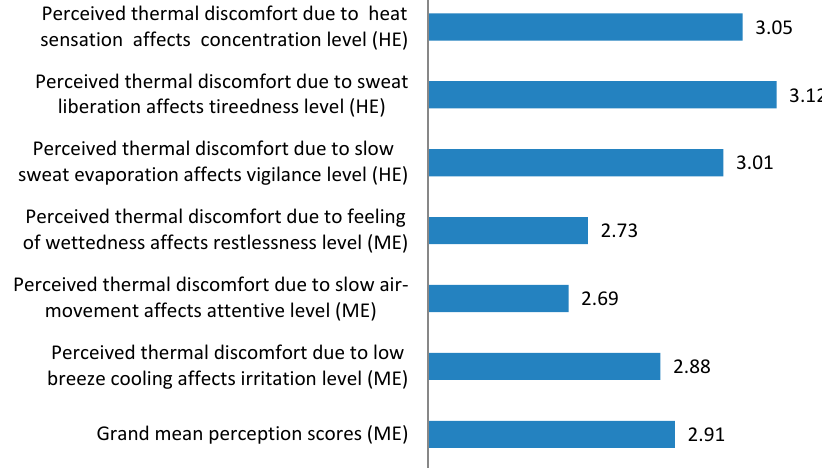
Figure 6. Students’ perceived stress behaviour level affecting learning in LTH-3.